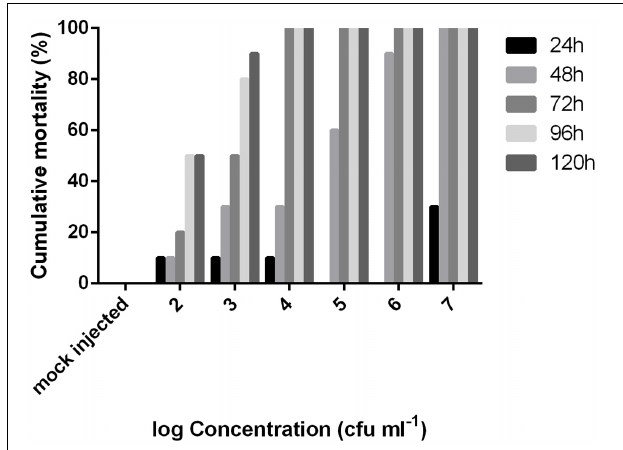
FIGURE 4 | Cumulative mortality of adult zebrafish challenged with various concentrations of Edwardsiella anguillarum strain EA011113 administered via intraperitoneal injection over a 5-day period. LD50 value was calculated at 48 h post